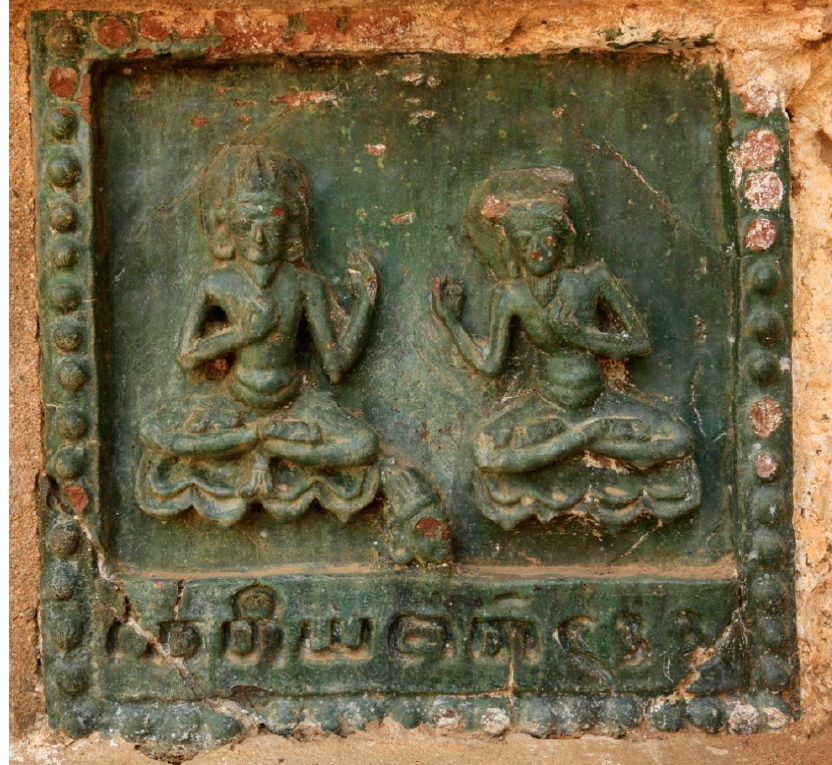
Figure 10. Pagan, Ananda Stupa, 11th Century, Jataka 422. Devadatta sinking into the earth, only the crowned head showing.